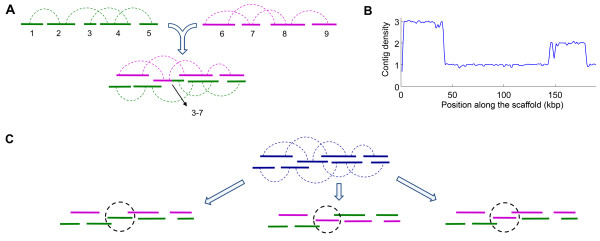
Detecting and resolving scaffold mis-assembly using density profile and Potts model. (A) Two scaffolds, shown in green and magenta, belong to the different regions of the genome. Mis-assembly of a chimeric contig composed of contig 3 from the green scaffold and contig 7 from the magenta scaffold causes the two distinct scaffolds to join together. In the new scaffold, many positions are covered by two contigs. (B) For a genuine scaffold, the density profile (see text for definition) should be close to one (or zero for gaps). The plot shows the density profile for a mis-assembled scaffold obtained in the assembly process of a real dataset from the E. coli genome. Each point along the x-axis represents a window of length 1000 bases along the scaffold. The y-axis shows the average density for positions located within each window. From this profile, we can infer that at least four scaffolds have been mis-assembled together. (C) Our labeling method for dividing contigs into distinct groups for the case shown in (A) can lead to any of the three possibilities shown here. We use color to present different labels. Note that the problematic contig (3-7) always lies at the boundary between different groups.